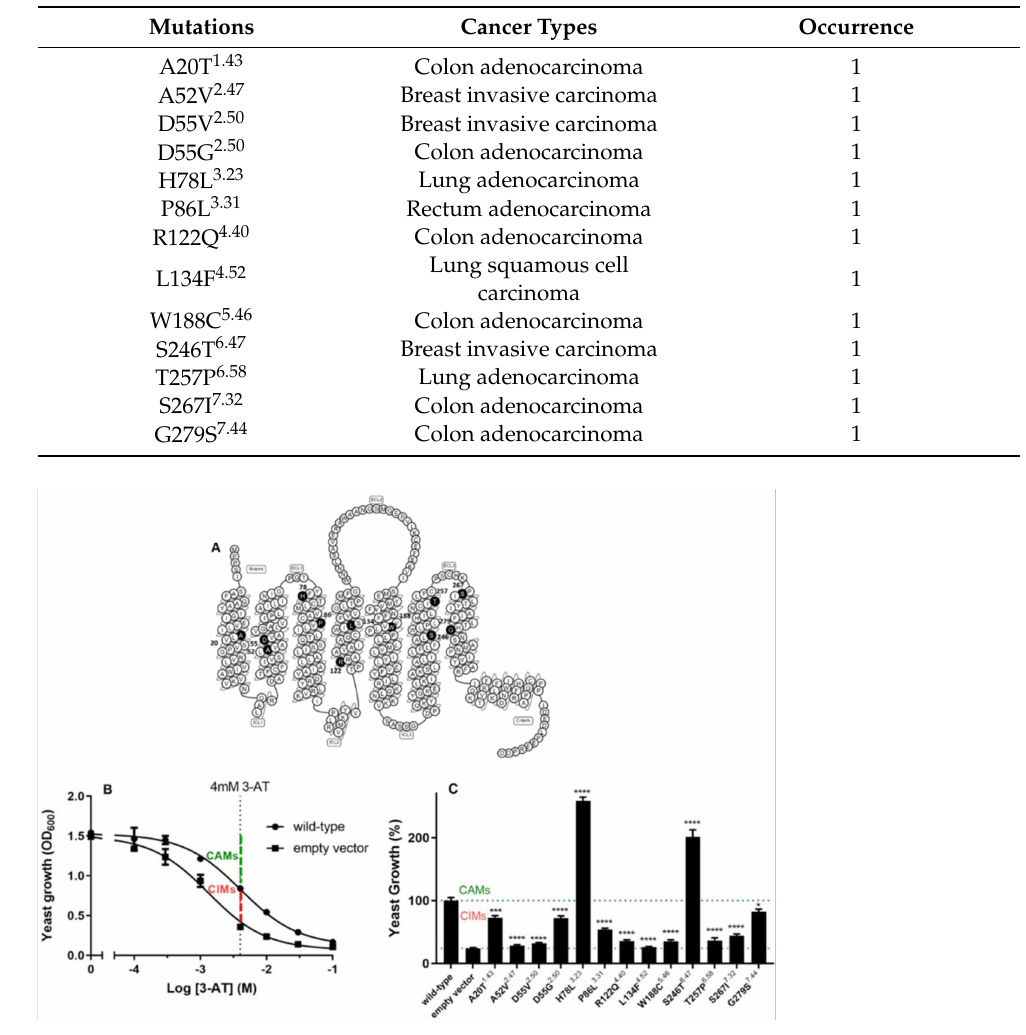
Figure 1. ( A ) Snake plot of wild type hA 1 AR. Mutated residues are marked in black. ( B ) Concentration– growth curves of the yeast strain in the presence or absence of wild type hA 1 AR. The combined graph is shown as mean ± SEM from three individual experiments performed in duplicate. ( C ) Constitutive activity of wild type and 13 mutant hA 1 ARs in the presence of 4 mM 3-AT. The yeast growth with wild type hA 1 AR was set to 100% and the background of the selection medium was set to 0%. The bar graph is the combined result of three independent experiments performed in quadruplicate. * p <